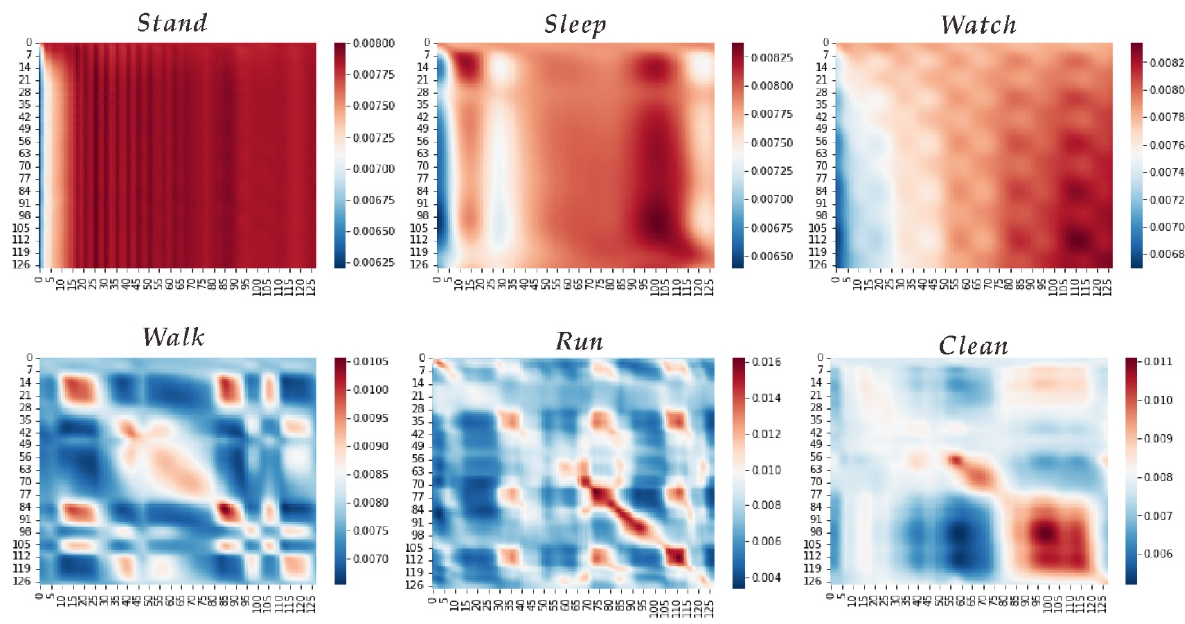
Figure 7. Visualization of TA on different human activities.